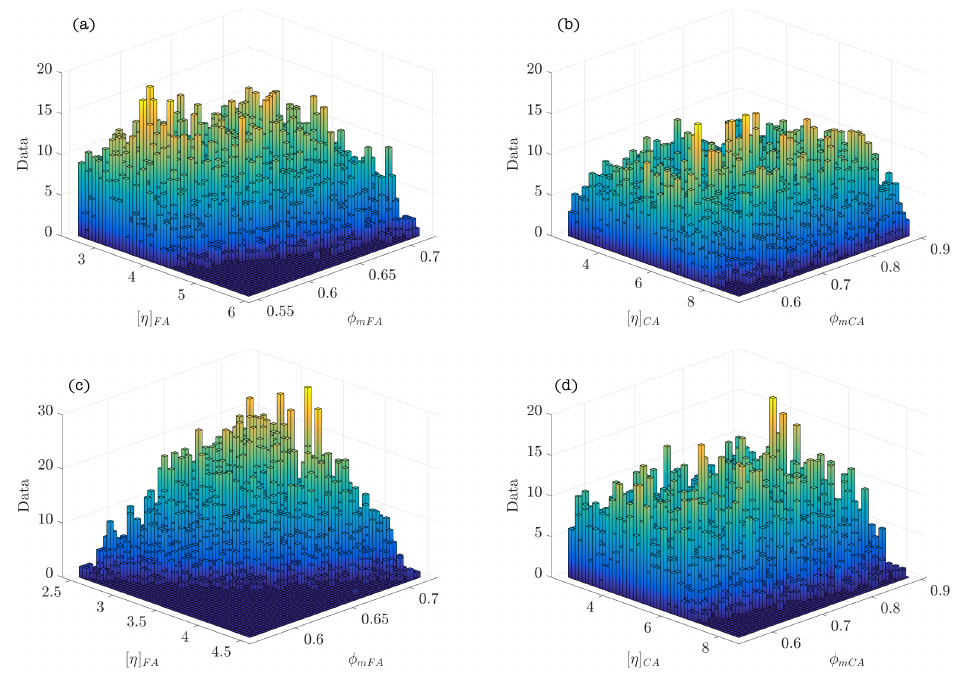
Figure 12. Bivariate histograms in every SCC phase: ( a ) [ η ] FA and φ mFA in Feys et al. [39]; ( b ) [ η ] CA and φ mCA in Feys et al. [39]; ( c ) [ η ] FA and φ mFA in Esmaeilkhanian et al. [40]; and ( d ) [ η ] CA and φ mCA in Esmaeilkhanian et al.